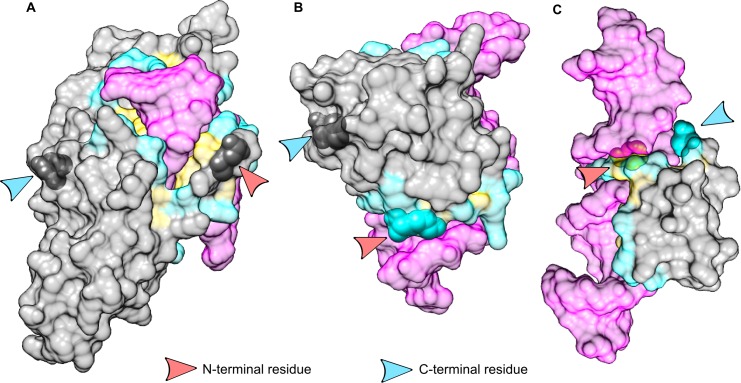
Examples of terminal residue implication at DNA-protein interfaces.A: complex between the restriction endonuclease HinP1 and DNA (PDB code 2FKC [35]). In this complex, protein terminal residues are genuine and none of them is involved in the DNA-protein interface. Orange spheres are calcium ions. B: complex between transcription factor PU.1 and DNA (PDB code 1PUE [36]). The N-terminal residue of the transcription factor (depicted in cartoon representation) is involved at the rim of the interface with DNA (pink surface). C: complex between the DNA binding domain of the C. elegans Tc3 transposase and DNA (PDB code 1TC3 [37]). The N-terminal residue of the protein is buried at the core of the interface and the C-terminal residue is involved at the rim of the interface. Protein interface is colored in yellow (core region) and cyan (rim regions). Terminal residues are represented as opaque spheres and highlighted by arrows. Images are generated using UCSF Chimera [30].